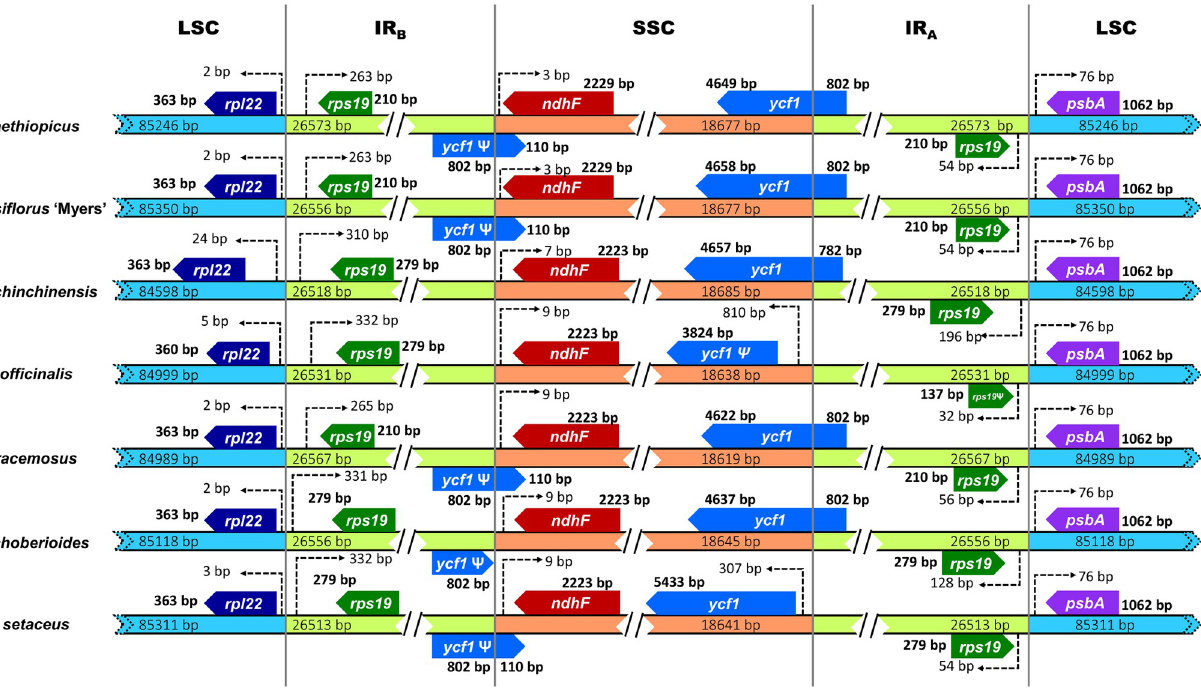
PLOS ONE | https://doi.org/10.1371/journal.pone.0266376 April 25,